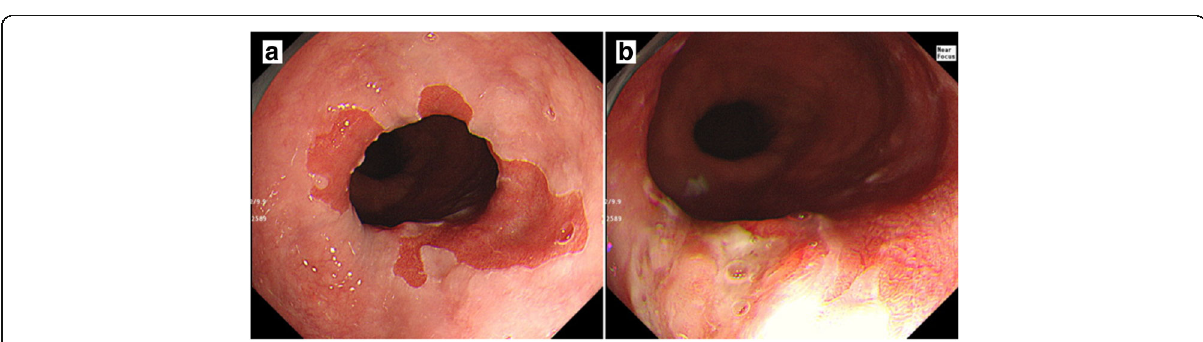
Fig. 1 Upper endoscopy. Upper endoscopy showed an elongated columnar epithelium from the squamocolumnar junction indicating BE ( a ) and a type 0-IIa + IIc elevated lesion adjacent to the BE lesion ( b )